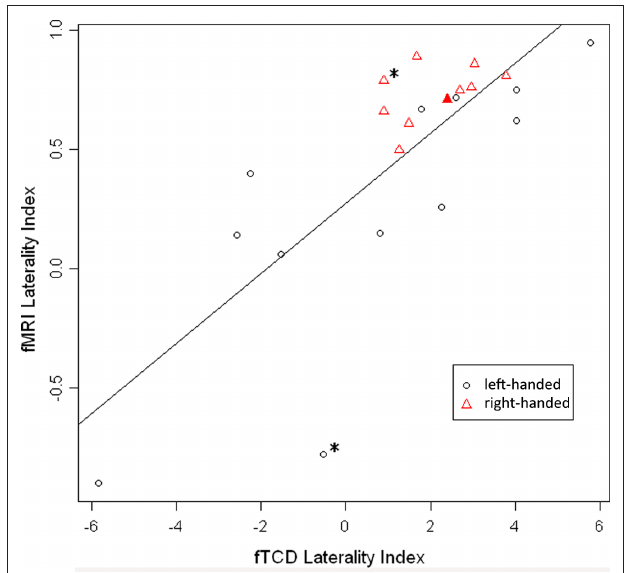
FIguRe 1 | Scatterplot of LI-fMRI ( − 1 < LI < 1) plotted against LI-fTCD ( − 6 < LI < 6). Red triangles: right-handed subjects. Black circles: left-handed subjects. Filled-out triangle: subject of which individual activation map is displayed ( Figure 2B ). “*” Indicates two subjects with an inaccurate fTCD measurement as shown by large confidence interval in Table 1 (subjects 5 and 17).